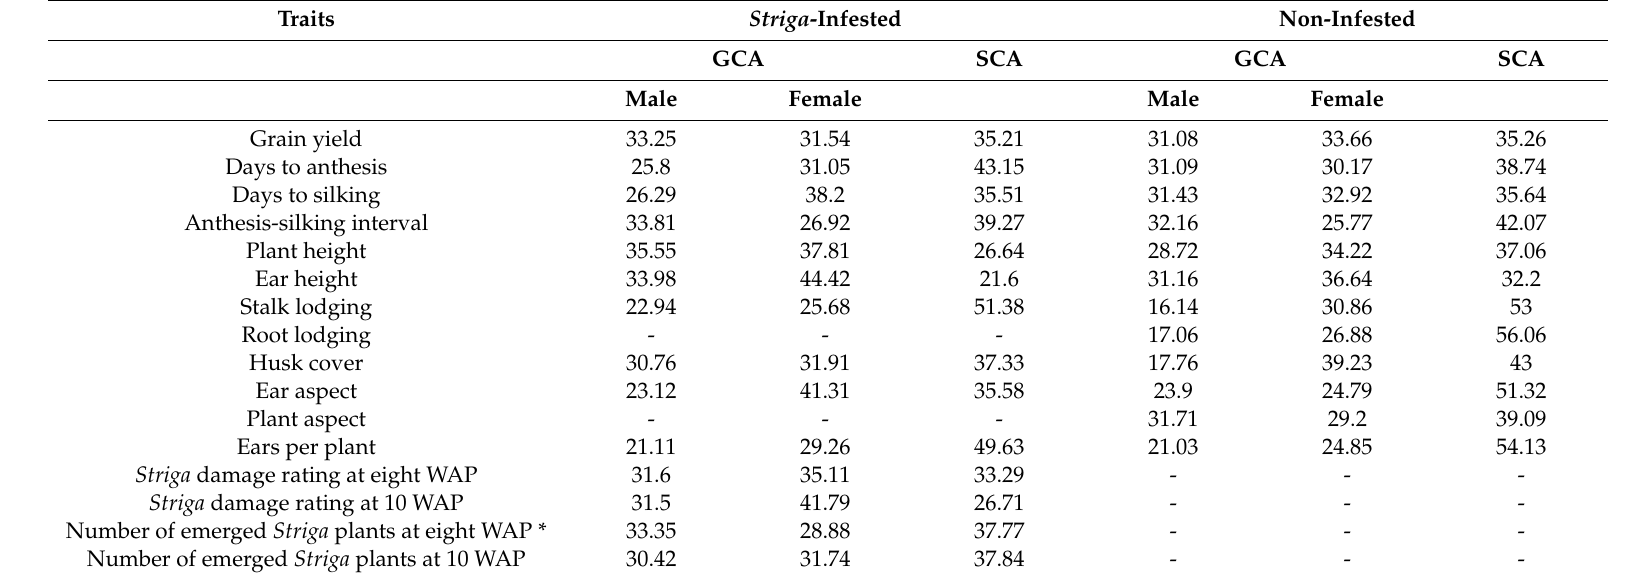
Table 4. Proportion (%) of the sums of squares for crosses attributable to general (GCA), specific combining ability (SCA) for grain yield and other agronomic traits of early white maize inbred